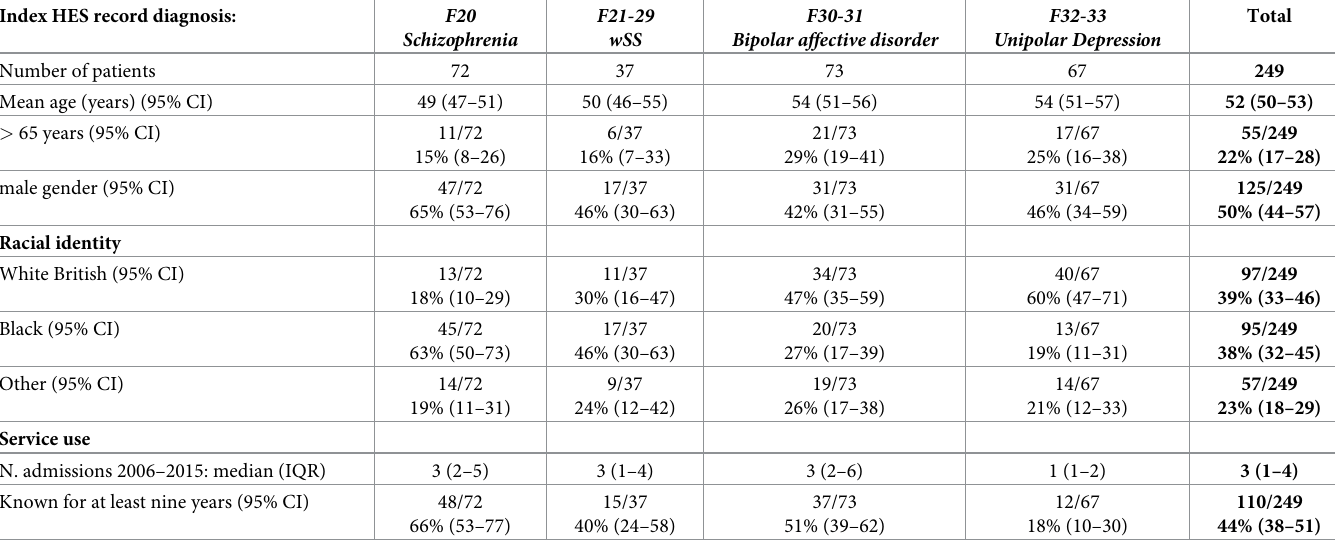
Table 1. Patient characteristics based on diagnosis in HES record by which they were selected.